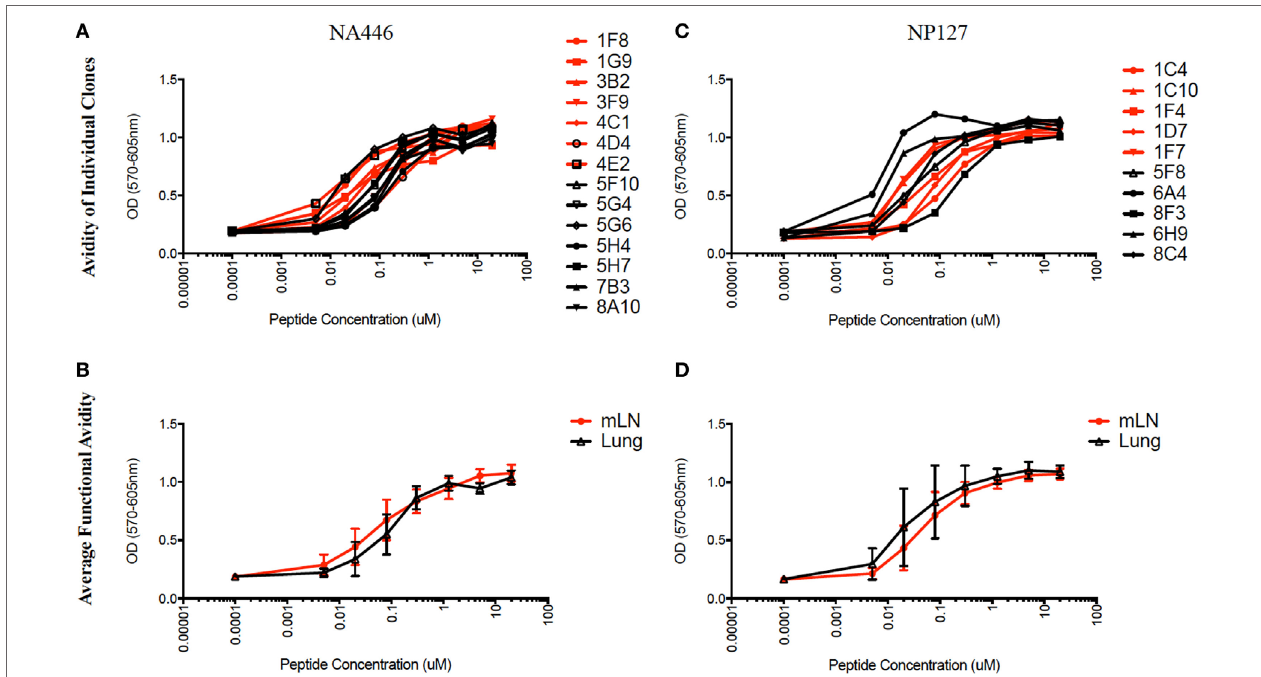
FigUre 8 | Similar range in functional TcR avidity from CD4 T cells isolated from dLN and lung. NA (NA446) and NP (NP127) specific T cell hybridomas, generated from CD4 T cells isolated from the mLN and lungs of infected mice at day 10 postinfection were assayed for their ability to produce IL-2 in EliSpot when restimulated with the indicated antigenic peptides at a range of doses (0.0001–100 μ M). (a) The left top panel shows the responses of clones specific for NA446 from the lymph node (black lines) and lung (red lines) and (c) the top right panel shows the response of clones specific for NP127 from the lymph node (black) and lung (red). (b,D) The bottom panels illustrate the average dose–response curves of the clones. IL-2 produced by the T cell hybridomas was quantified using CTL.L and MTT assays.